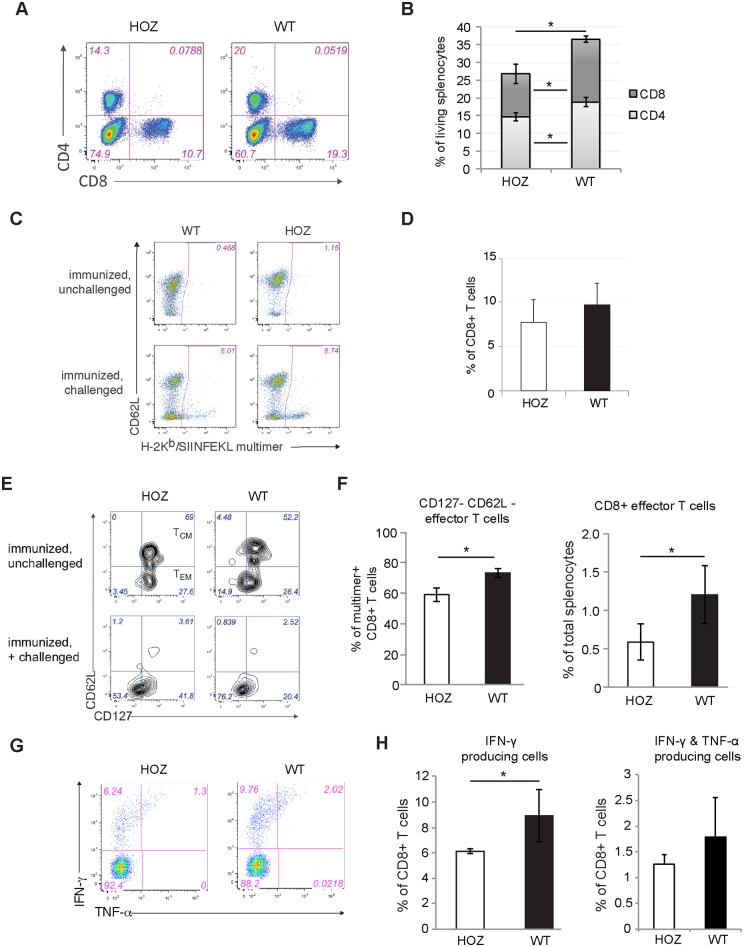
Impaired T-cell activation in CIP2AHOZ mice in vivo.(A-H) Flow cytometry analysis of splenocytes from 3 WT and 4 CIP2AHOZ mice five days after recall infection with high-dose L.m.-OVA. (A) Representative flow cytometry analysis for CD4+ and CD8+ T cells. (B) Percentage of CD4+ and CD8+ splenocytes from analysis described in (A). * p < 0.05, Two-tailed T-test. (C) Representative dot plots of antigen-specific CD8+ T cells identified by H-2Kb/SIINFEKL multimer staining. Dot plots are gated on living CD45+ CD3+ CD8+ cells. (D) Bar chart numbers indicate H2-Kb/SIINFEKL multimer+ cells as percentages of CD8+ T cells. T-test. (E-H) Analysis of OVA-specific CD8+ T lymphocytes from control and mutant mice 5 days after recall infection with high-dose L.m.-OVA and unchallenged control mice. (E) CD62L and CD127 surface expression on OVA-specific (H-2Kb/SIINFEKL multimer+) allows the characterization of secondary T-cell subsets: central memory phenotype (TCM, CD127+ CD62L+) and effector memory phenotype (TEM, CD127+ CD62L-) can be observed in immunized, unchallenged mice; whereas immunized challenged mice present two main populations of effector T cells differentiated by their CD127 expression. (F) Bar chart numbers indicate percentages of effector phenotype CD8+ T-cells in regards of total splenocytes or OVA-specific CD8+ T lymphocytes (right). * p < 0.05, Two-tailed T-test. (G) Cytokine production by antigen-specific T-cells from CIP2AHOZ and WT mice on day 5 after recall infection with high-dose L.m.-OVA. (H) Proportion of TEM and TCM from total splenocytes. * p < 0.05, Two-tailed T-test.